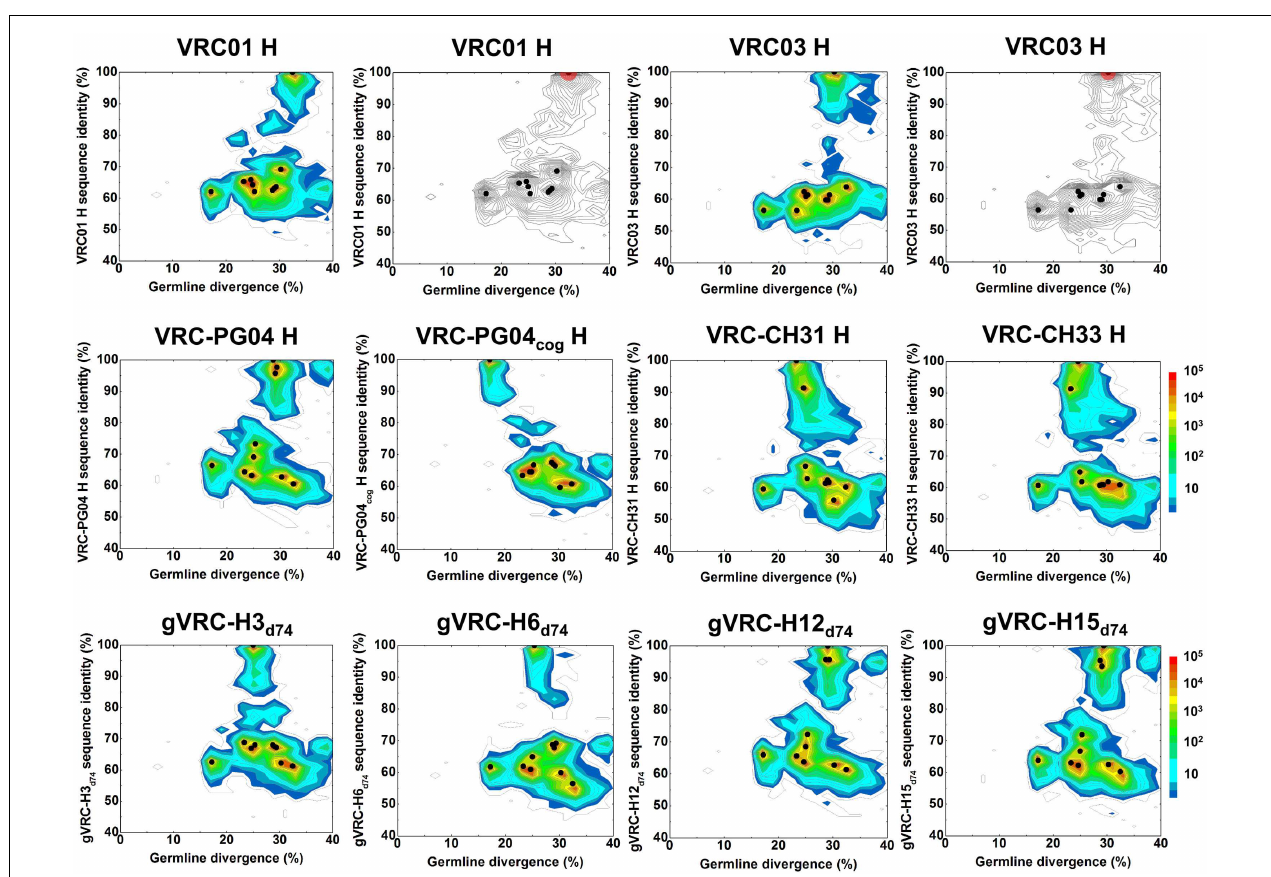
antibody (vertical axes) and of sequence divergence from their germline gene allele, IGHV1-2 ∗ 02 (horizontal axes).The sequencing data used for divergence/identity analysis was processed by the standard bioinformatics pipeline without the error-correction step. Color coding indicates the number of sequences. ForVRC01 andVRC03, additional contour plots displaying the estimated mutational error range (one root-mean-square deviation, 1.38% for VRC01 group and 1.26% forVRC03 group) have been shaded red around the input